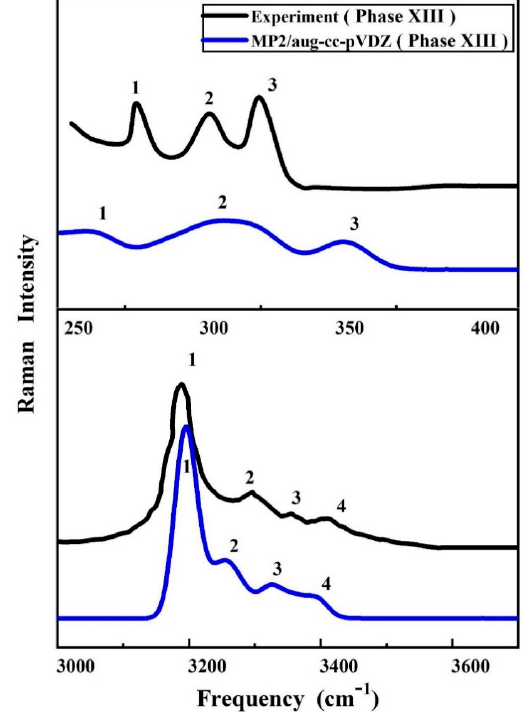
Figure 3. The calculated and observed [50] Raman spectra of ice phase XIII at 10 MPa. The calculated spectra are performed using the EE-GMF-MP2/aug-cc-pVDZ method.